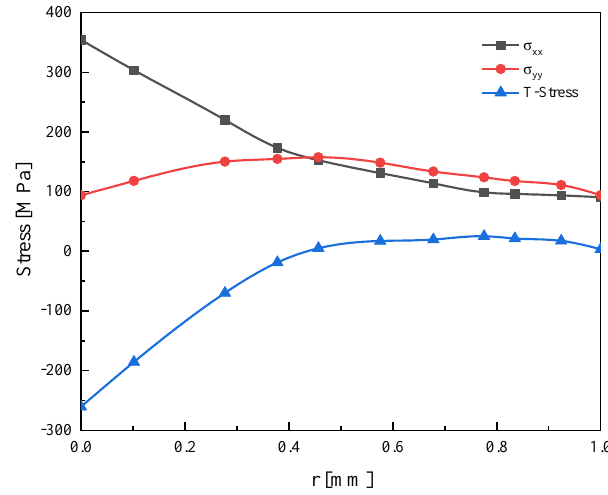
Figure 5. T-stress by stress different method.